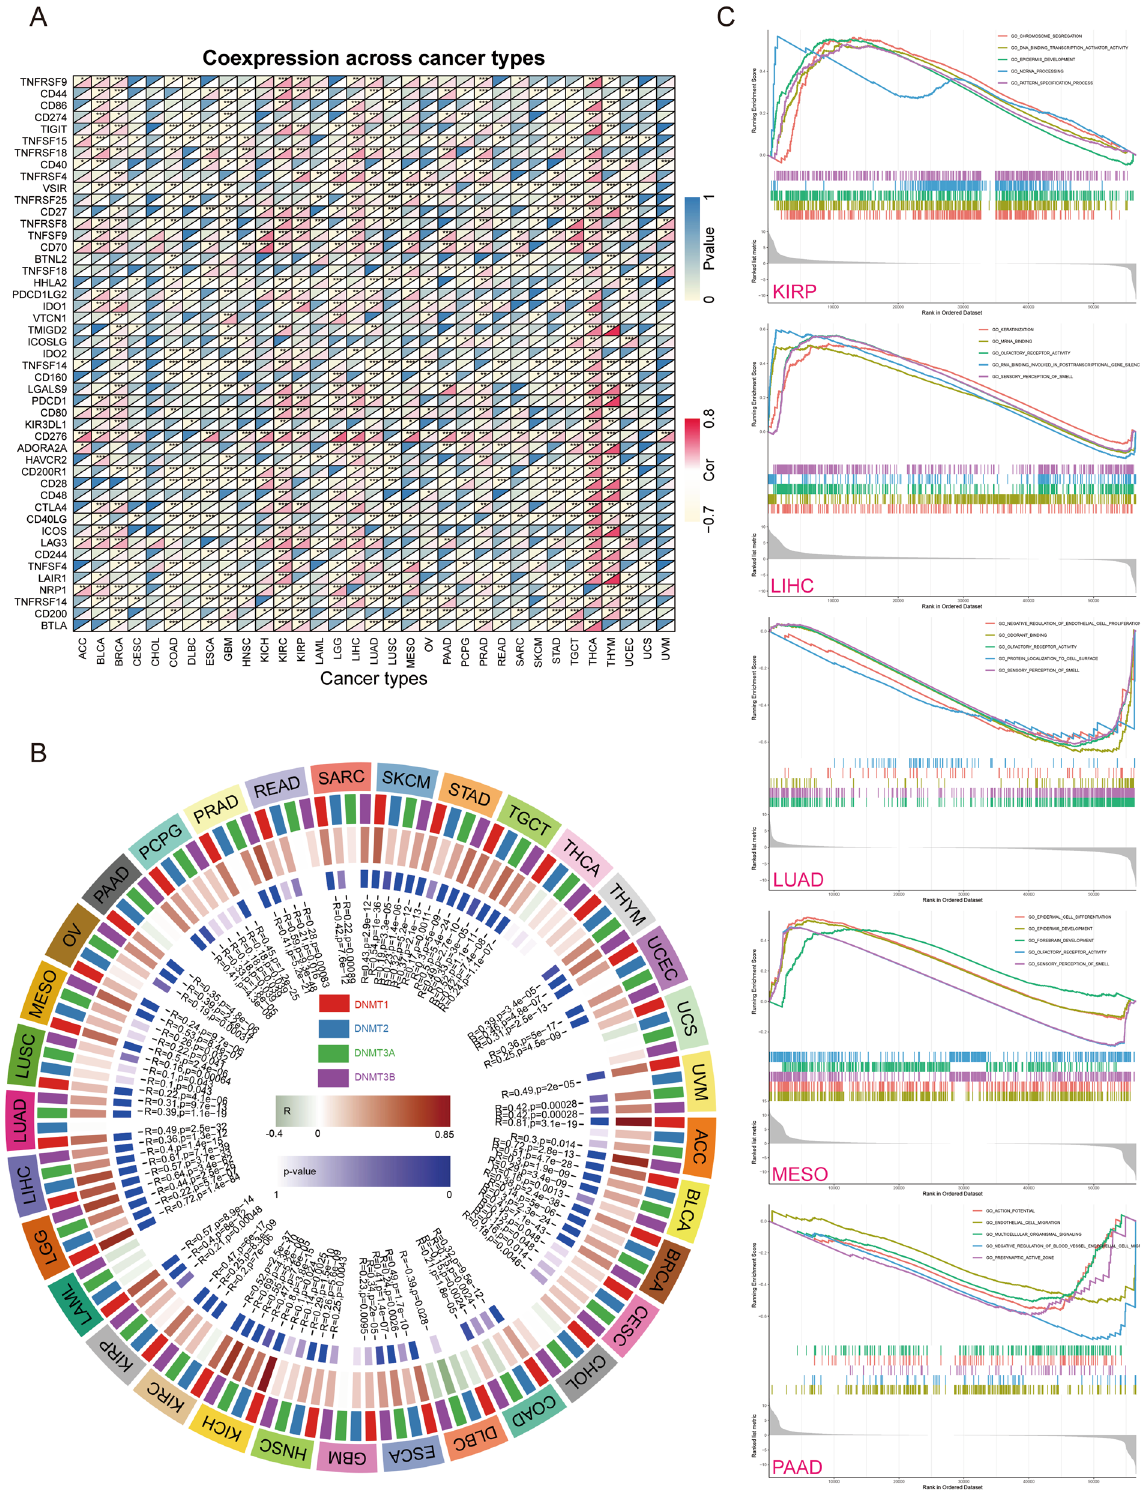
Figure 6. The relationship between BIRC expression and immune related genes. ( A ) The correlation between BIRC5 expression level and immune checkpoint gene expression. ( B ) The relationship between the expression level of BIRC5 and 4 methyltransferases. ( C ) GSEA analysis of BIRC5 in five kinds of tumors whose prognosis is closely related to the expression of BIRC5. The figure was performed using R version 3.6.1 (2019-07-05) 46